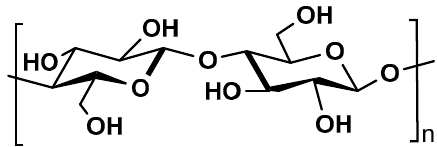
Figure 5. Chemical structure of cellulose.